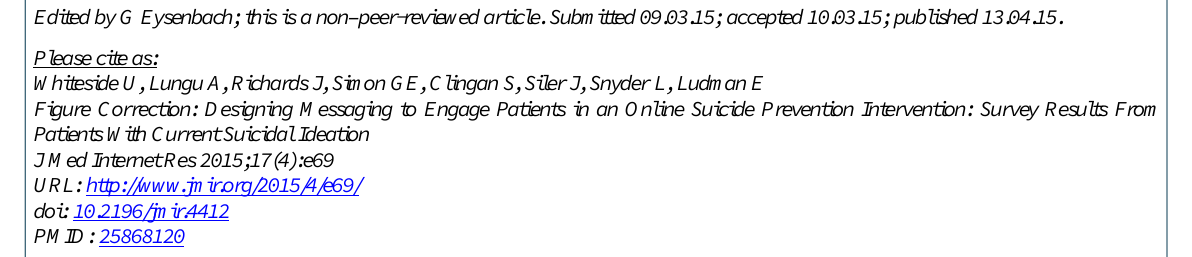
Figure Correction: Designing Messaging to Engage Patients in an Online Suicide Prevention Intervention: Survey Results From Patients With Current Suicidal